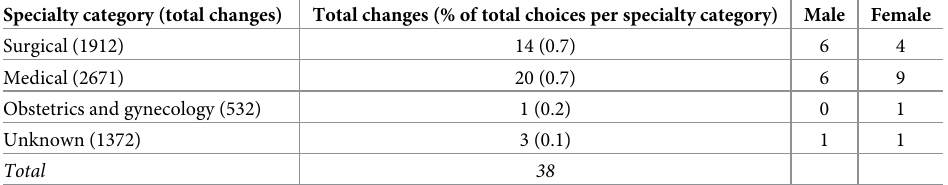
Table 4. Number of changes to radiology and pathology test result preferences per specialty